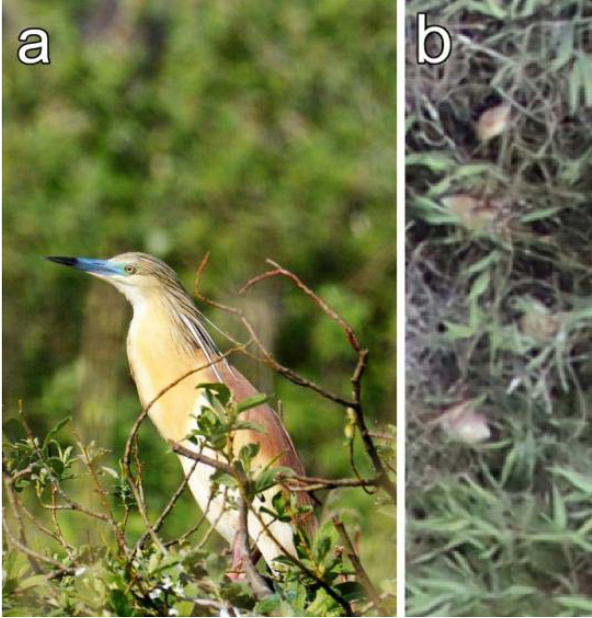
Figure 5. A Squacco Heron captured ( a ) on ‐ site and ( b ) from above (captures by Edina Morvai and Gábor Bakó).